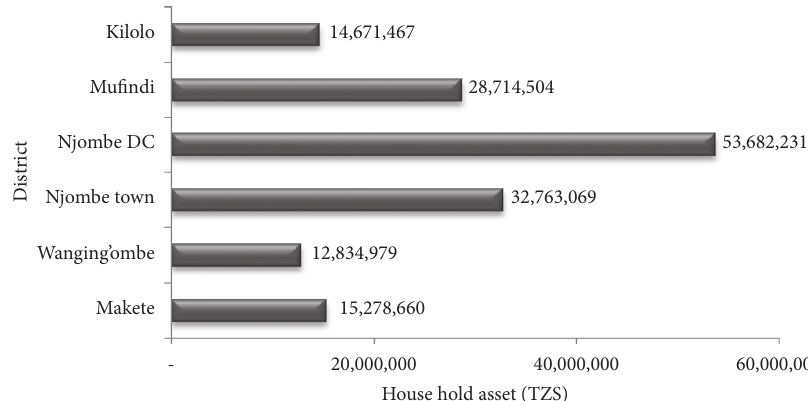
Figure 4: Results on household assets (source: own field